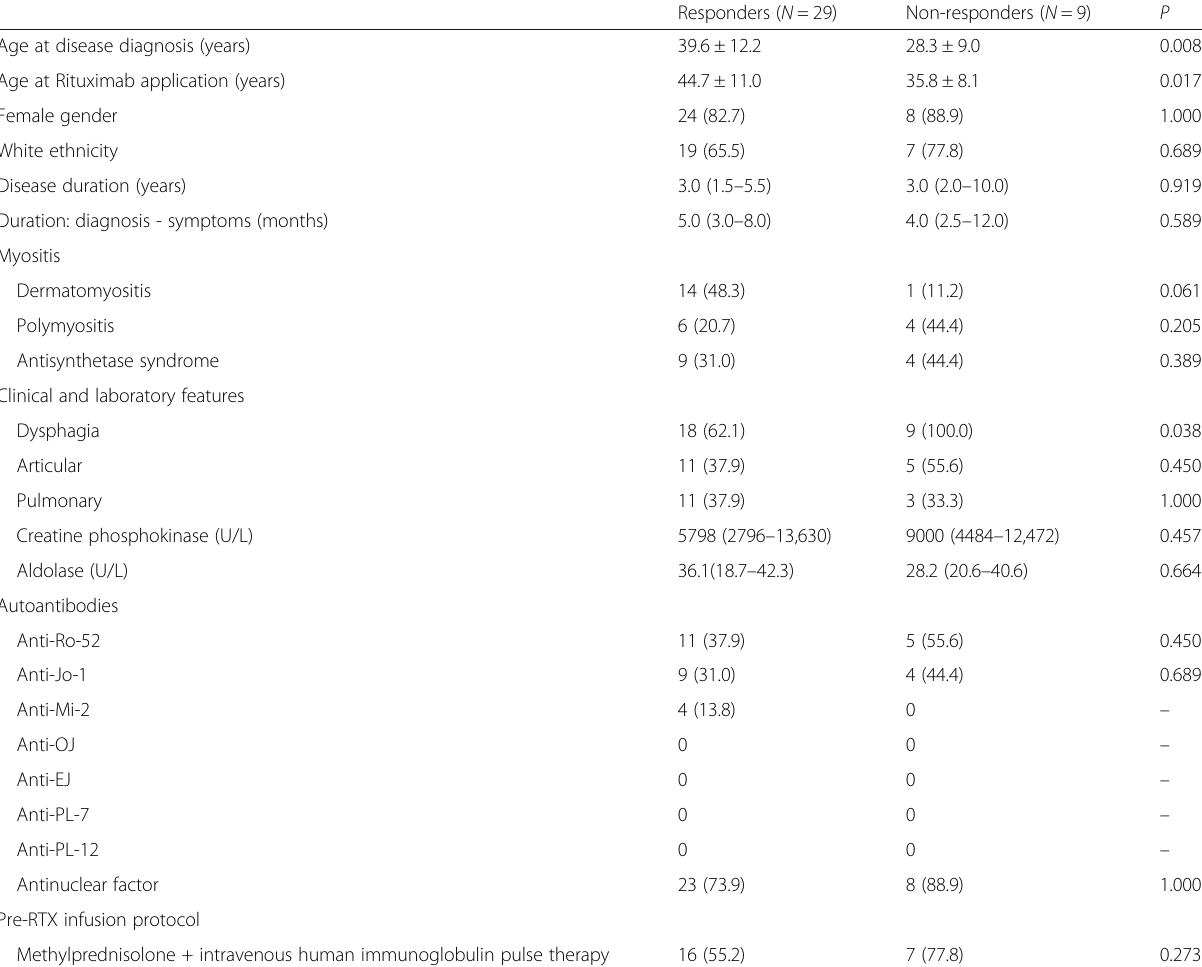
Table 3 Frequency of rituximab response according to myositis type, clinical involvement, autoantibody profile and